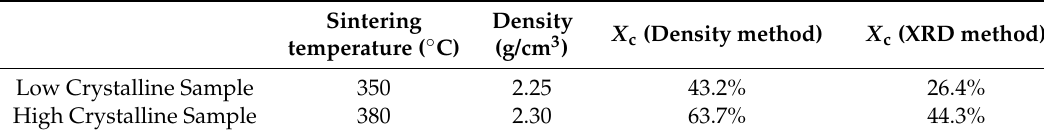
Table 1. Crystallinity of PTFE calculated by the density method and XRD method.